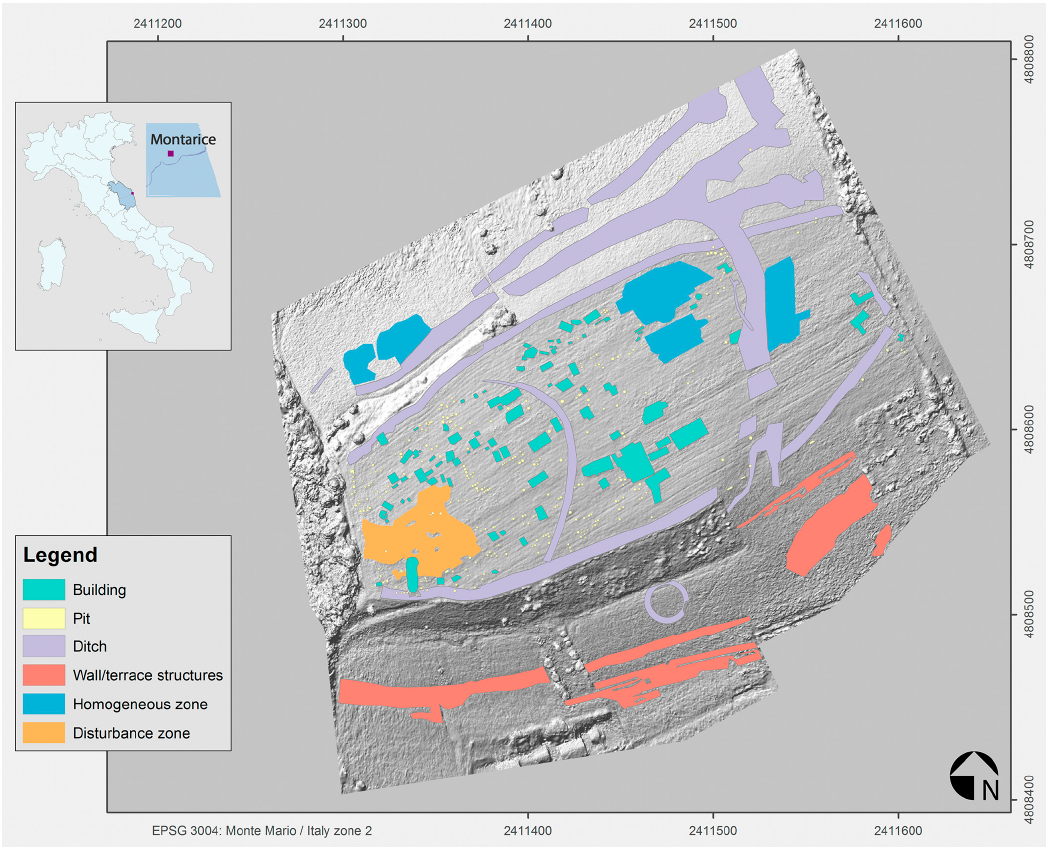
Figure 5. The interpretative map of Montarice, based solely on archived aerial imagery and data layers extracted from them.